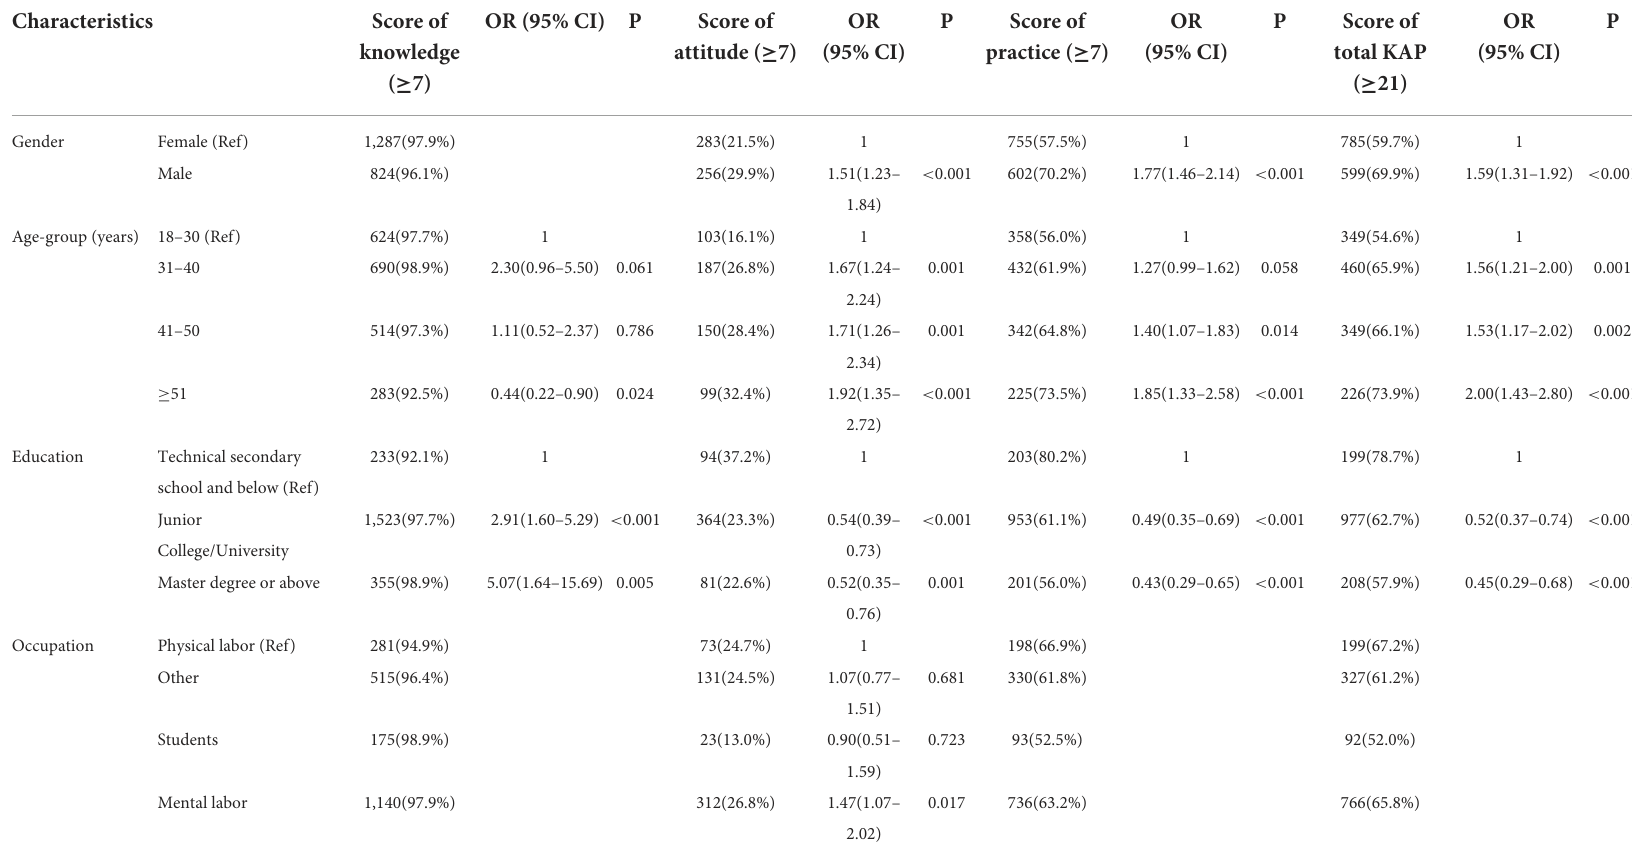
TABLE 6 Comparison of different COVID-19-related knowledge, attitude, and practice scores according to different participant characteristics.